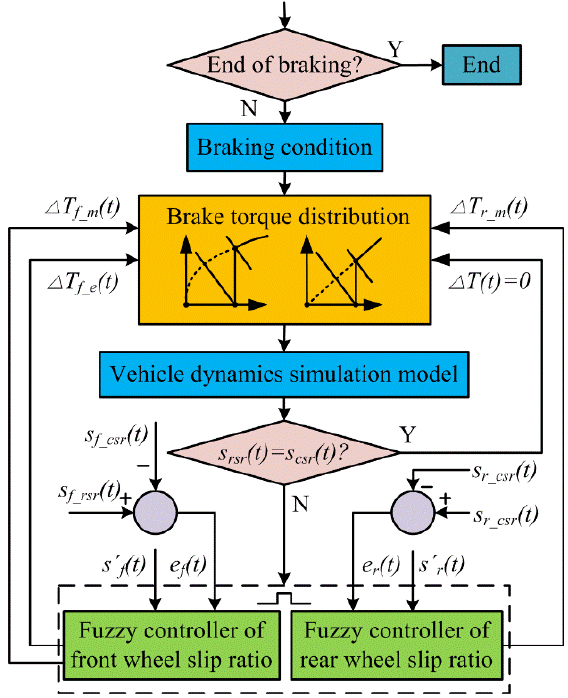
Figure 4. Diagram of the optimal slip ratio control process by the double fuzzy logic controller (DFLC).